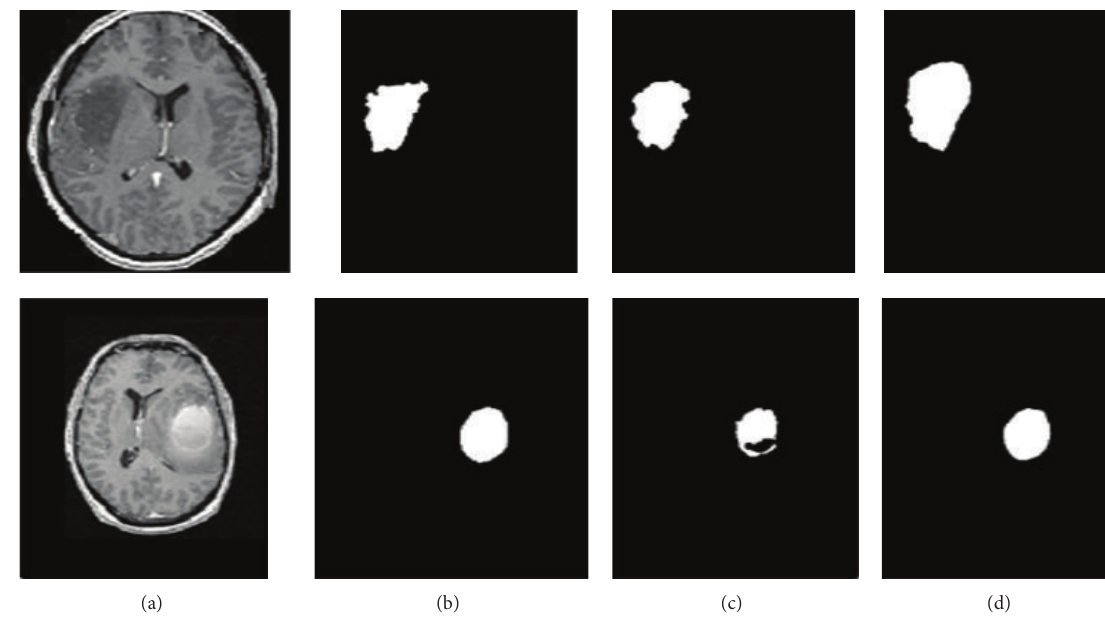
Figure 8: Tumor segmentation results on real-time datasets: (a) original MRI segmentation by (b) expert, (c) 2D GLCM+2D RLM+2D centroid model, and (d) proposed 3D GLCM+3D RLM+3D centroid model.